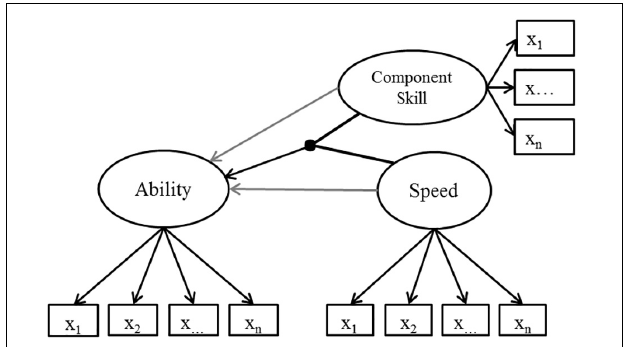
FIGURE 2 | Structural model to investigate how the component skills [perceptual speed (PS) and word meaning activation (WMA)] moderate the relation between speed and ability in reading and reasoning tests (latent correlations are